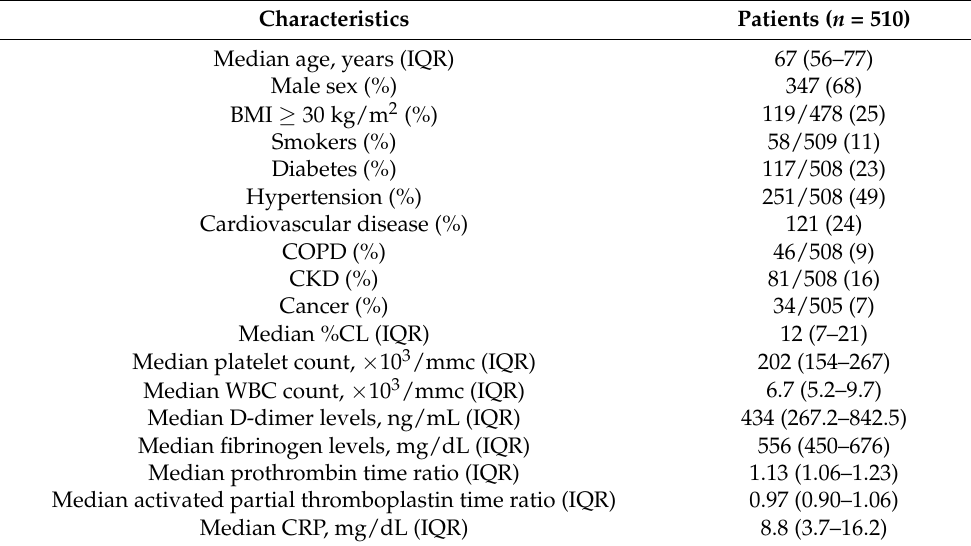
Table 1. Main characteristics of the 510 consecutive patients admitted to the emergency room with COVID-19 pneumonia included in the study.